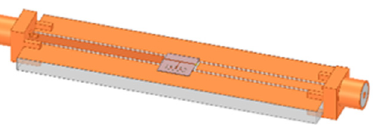
Figure 6. Photograph of ( a ) Top view of fabricated sensor; ( b ) Lateral view with liquid injection accesses and tubing; ( c ) Experimental set up with equipment.